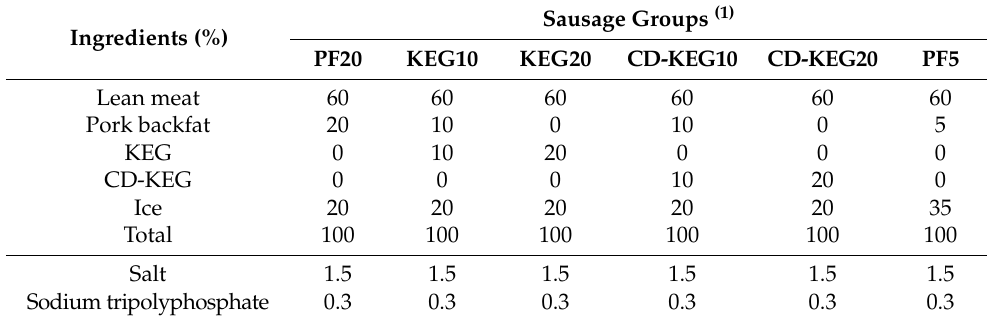
Table 4. The formulation of emulsion gel-supplemented